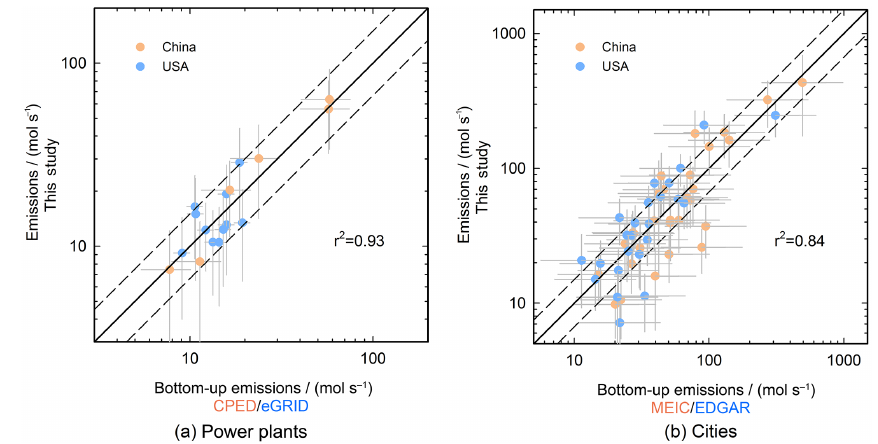
Figure 7. Scatter plots of the derived NO x emissions for investigated (a) power plants and (b) cities versus bottom-up emission inventories. Emissions are given in mols − 1 calculated assuming a constant emission rate. Urban emissions from bottom-up inventories are integrated over 40km × 40km (see text). Error bars show the uncertainties for emissions by this method (see Sect. 2.3) and bottom-up inventories (see Sect. 2.4). The straight and dashed lines represent the ratio of 1 : 1 and 1 . 5 : 1 / 1 : 1 . 5, respectively.